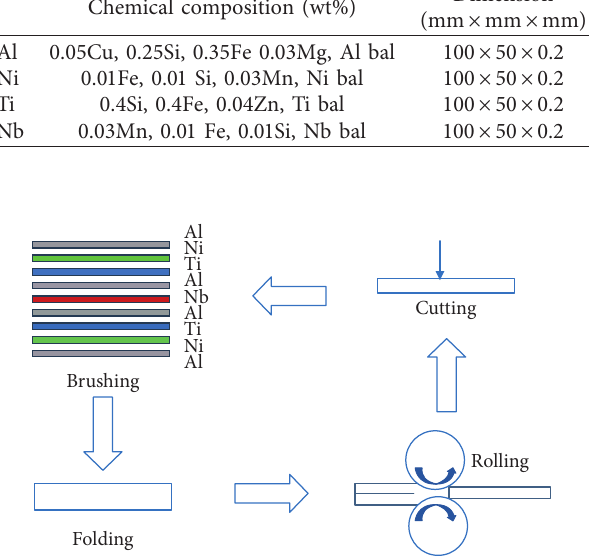
Table 1: Chemical composition and dimensions of the used sheets. Chemical composition (wt%)